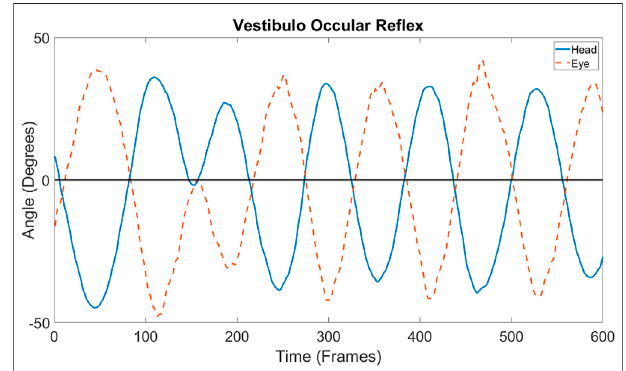
FIGURE 2 | Example of uncorrected measurement for a VOR task involving horizontal head rotation. The horizontal axis indicates time in frames recorded at 120 frames per second. The vertical axis represents a) angle relative to fi xation target for the head (blue solid line), where 0 ° s indicates the head is pointed directly at the fi xation target and b) angle of combined eye gaze vector relative to the head (orange dashed line) where 0 ° s indicates that the eye vector is directed parallel to the head